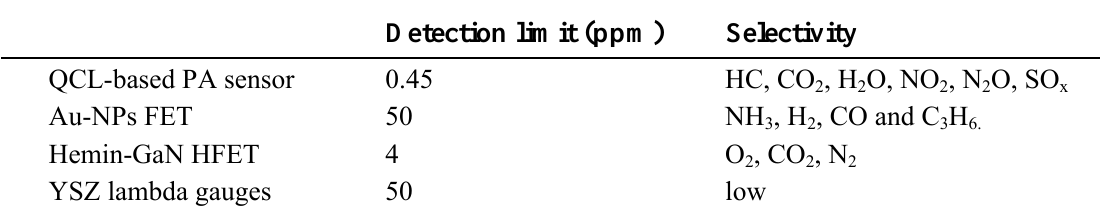
Table 3. Detection limit and selectivity values of QCL-based PA sensors, Au-NPs FETs, Hemin-GaN HFETs and commercial YSZ lambda